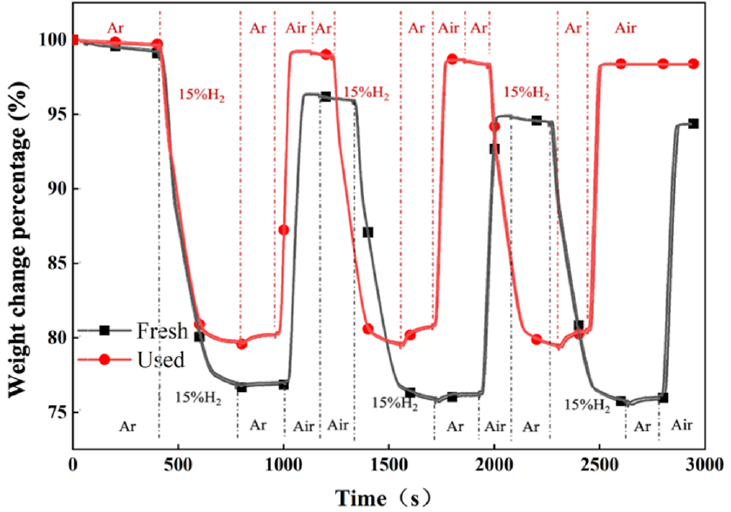
Figure 12. Thermogravimetric curves of fresh and used oxygen carriers at 950 ◦ C, cycles with 15% H 2 in reduction, Ar in inert, and air during oxidation.